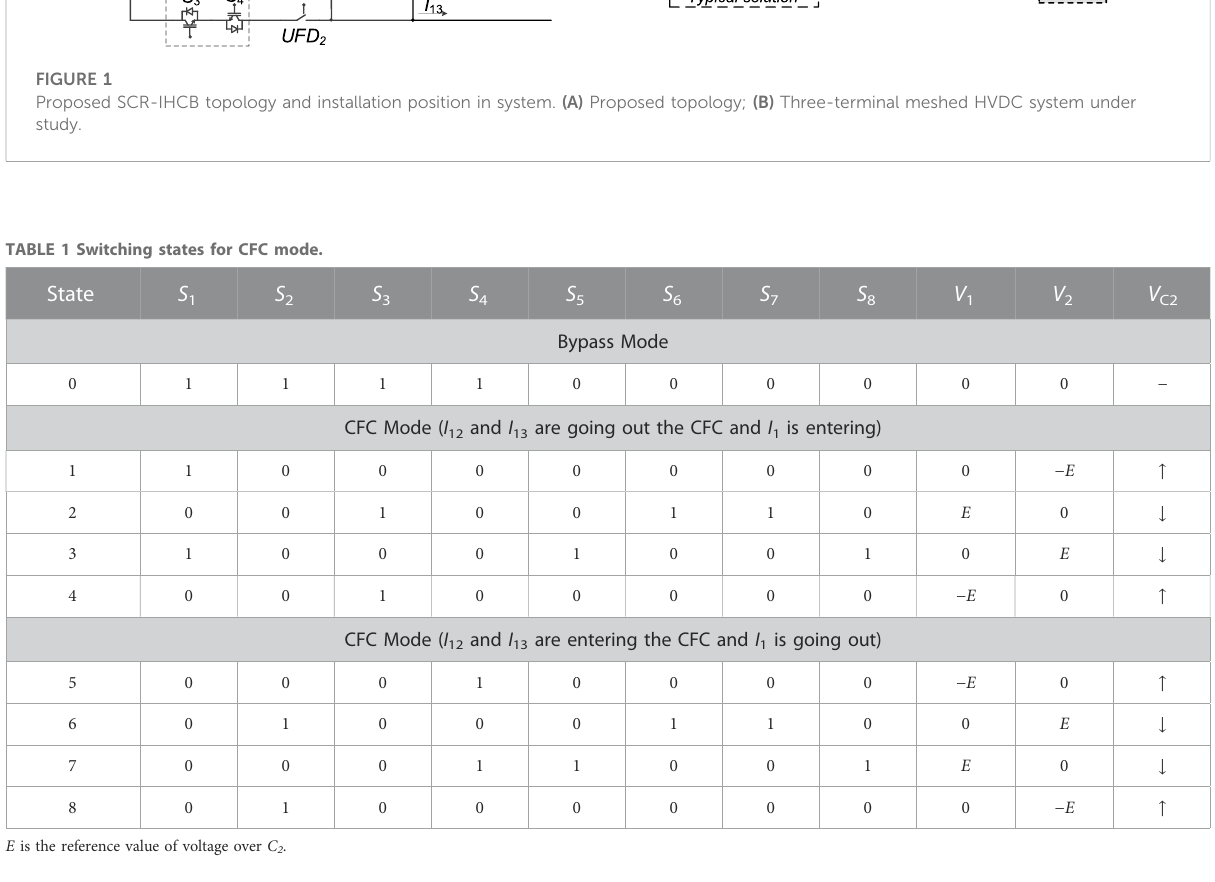
SCR-IHCB and I 1 is entering) are considered as an example. In order to transfer power from line13 to line 12, the CFC should switch continuously in state 1 and state 2 by alternating